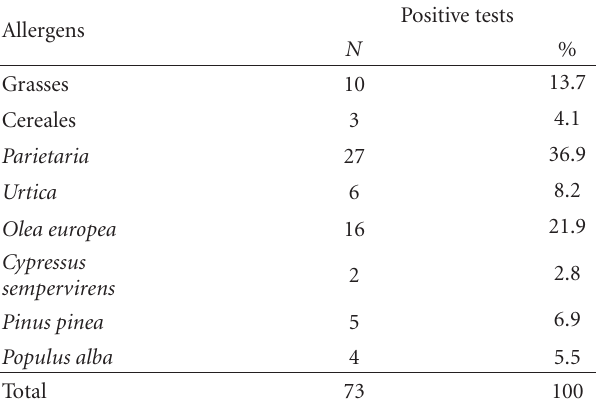
Table 3: Positive RAST (and skin prick test when performed) to various allergens in intermittent allergic rhinitis.